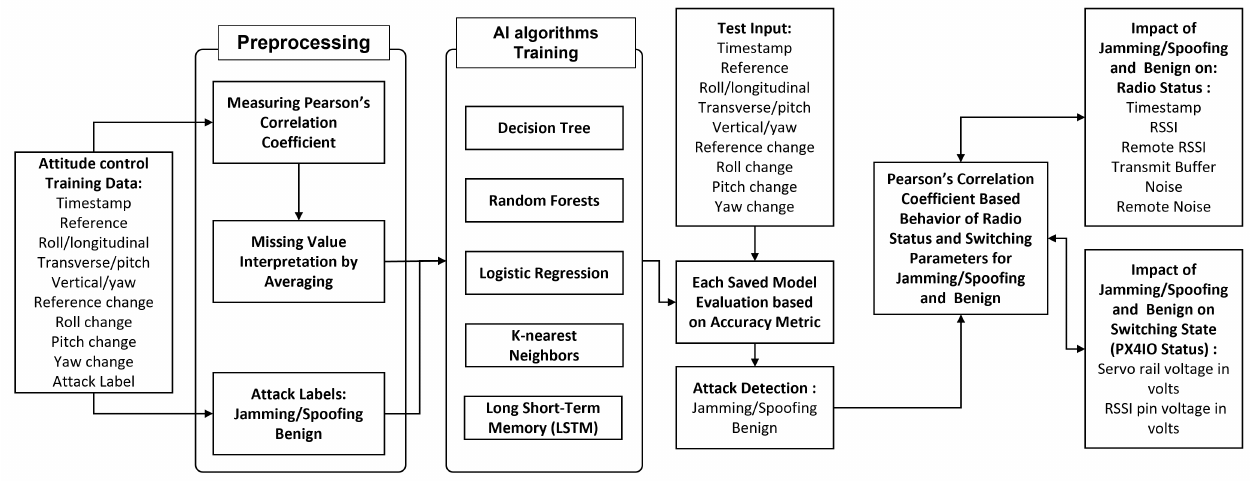
Figure 6. Block diagram of overall methodology with inputs and